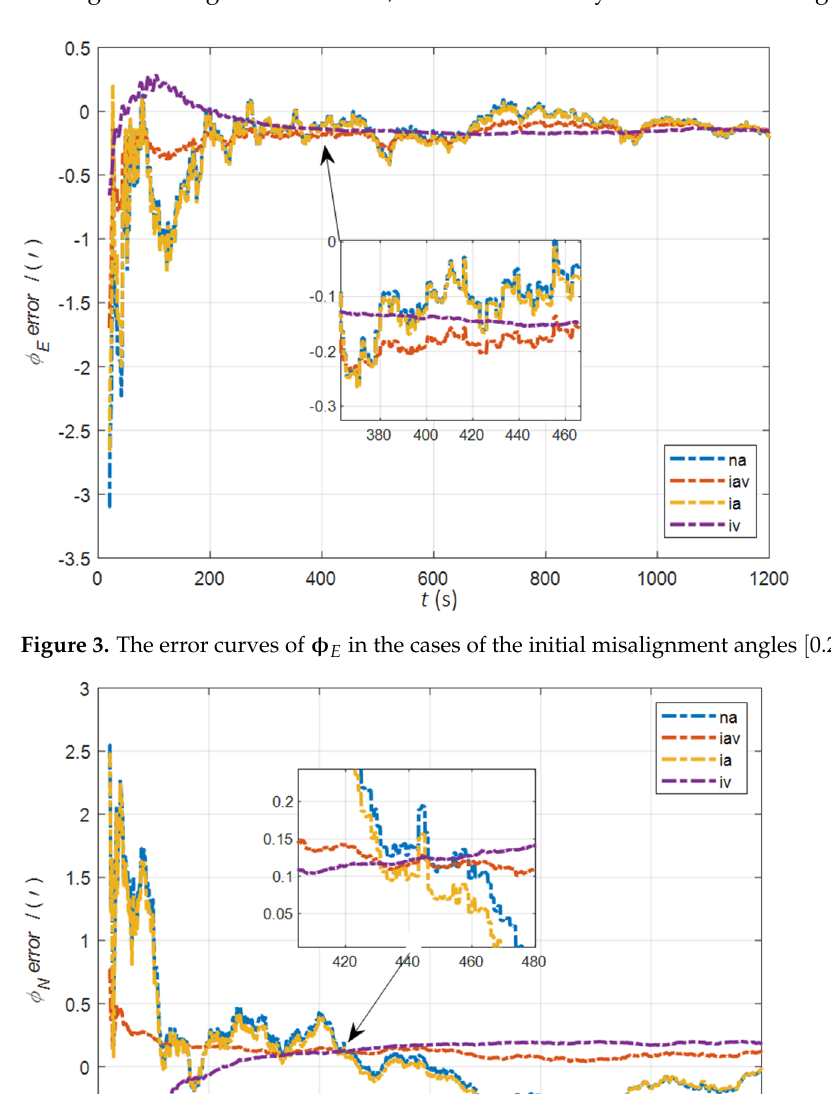
Figure 2. The curves of the dynamic deflection angle in the quasi-static swing base.